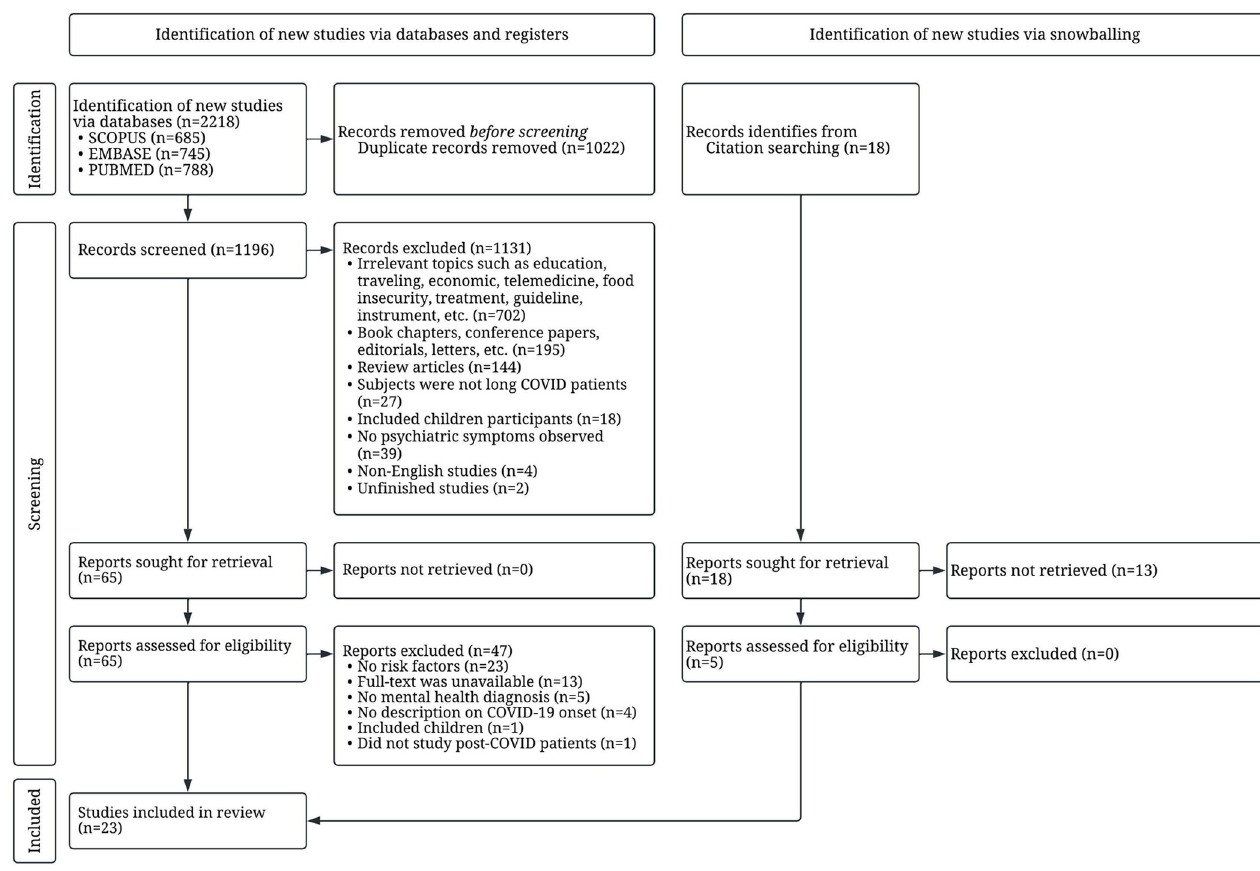
Fig 1. Study selection using PRISMA flow